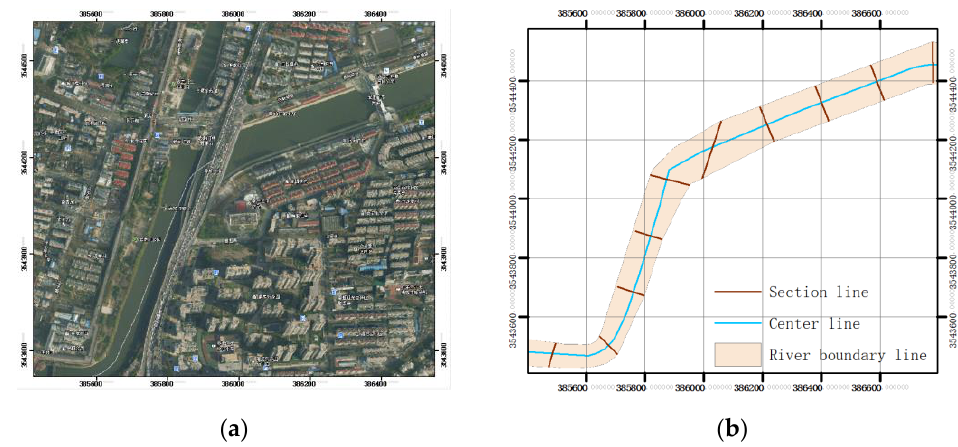
Figure 7. Section position. ( a ) Image map; ( b ) river boundary: center line and section lines.